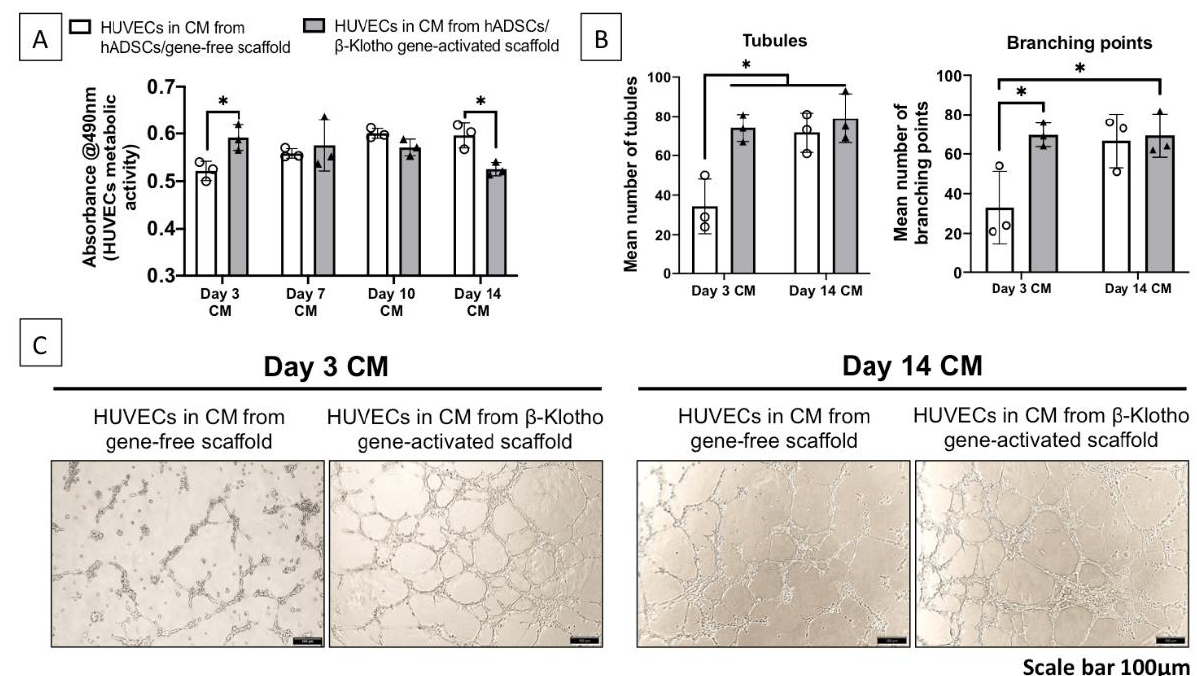
Figure 2. Pro-angiogenic paracrine bioactivity of the ADSCs-laden gene-activated scaffold CM. ( A ) CM produced by the ADSCs-laden gene-activated scaffold over the 14 days demonstrated an ability to temporally control HUVECs’ metabolic activity. ( B ) Day 3 CM from the gene-activated scaffold group significantly enhanced endothelial tubule formation and its branching compared to that of the gene-free scaffold group. ( C ) Tubule formation and branching of endothelial cells 6 h post-exposure to CM from the ADSCs seeded gene-activated and gene-free scaffold. * indicates p < 0.05. Data represents mean ± standard deviation ( n = 3).